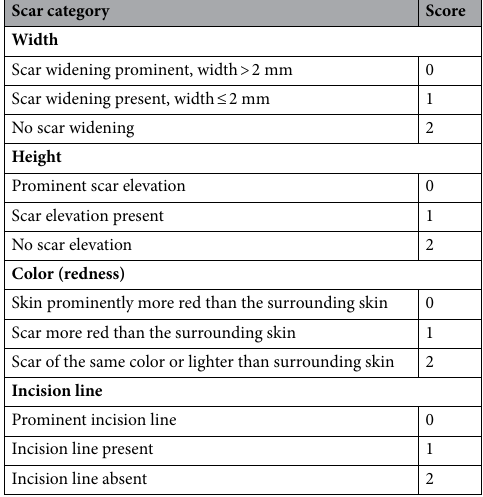
Table 1. Modified Stony Brook scar evaluation scale